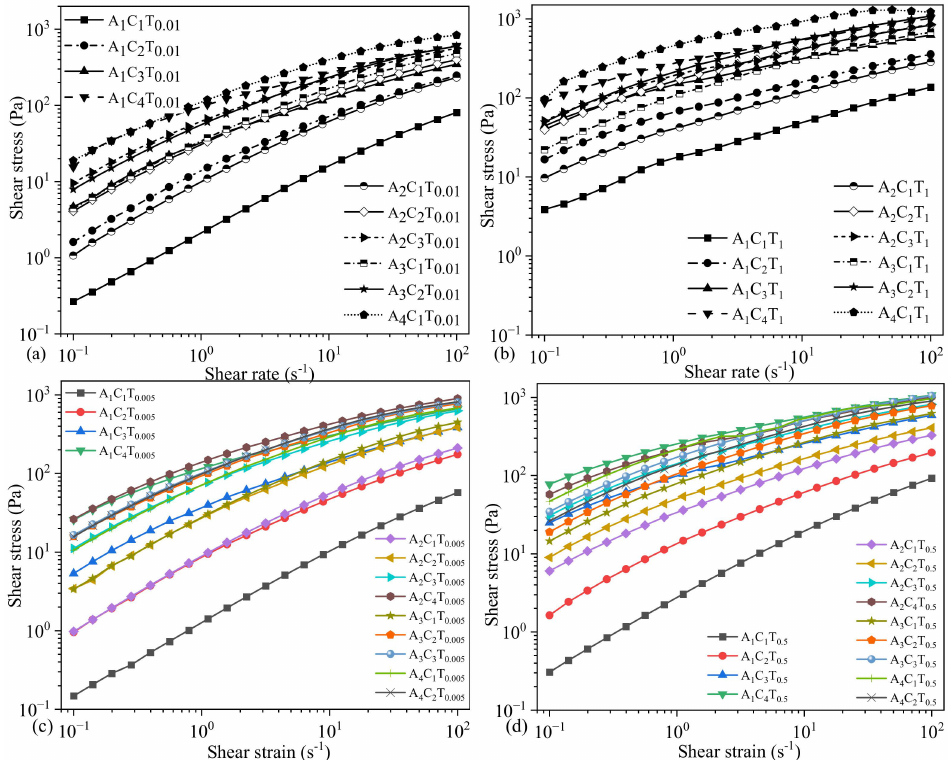
. γ n . γ ) prepared with different weight percentages